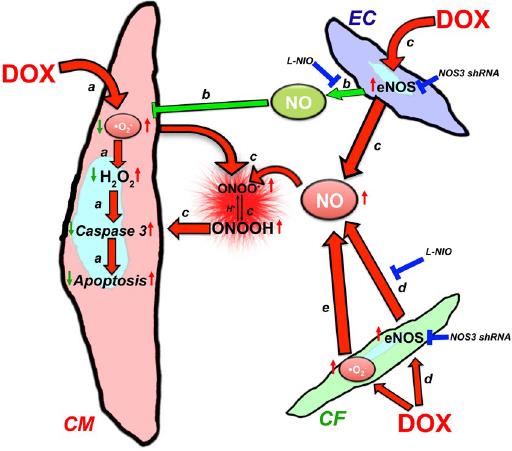
Figure 7. Cross-talk between different cell types in DOX-induced cardiotoxicity. ( a ) DOX-induced effects on cardiomyocytes occurs via ROS/caspase 3-mediated apoptosis. ( b ) EC-released NO protects cardiomyocytes against DOX-induced toxicity. ( c ) DOX-induced eNOS up-regulation in endothelial cells produces toxic NO species. ( d ) DOX-induced eNOS up-regulation in cardiac fibroblasts produces the majority of the toxic NO species. ( e ) DOX-induced cardiotoxic effects via ROS production in cardiac fibroblasts. At the molecular level, DOX/superoxide-induced apoptosis in cardiomyocytes can be either rescued by endothelial